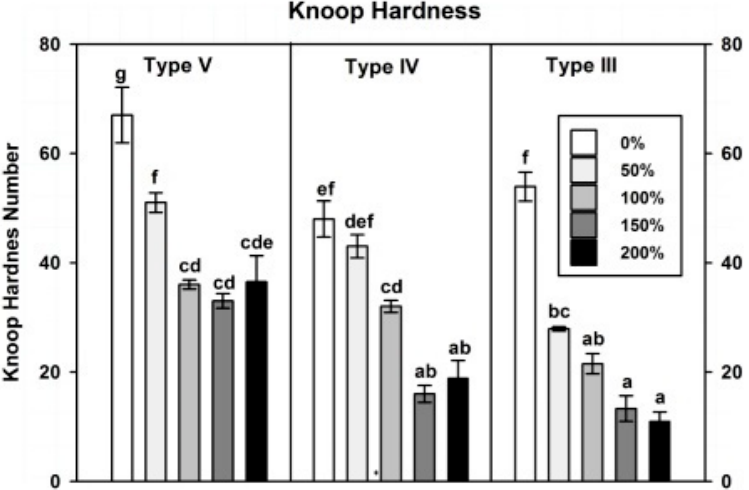
Figure 2. Bar chart of five-day Knoop hardness for three gypsum types and five water dilutions. Error bars represent standard errors of means; groups with different letters are significantly different at α = 0.05 confidence level. Comparisons are both within and across gypsum types.